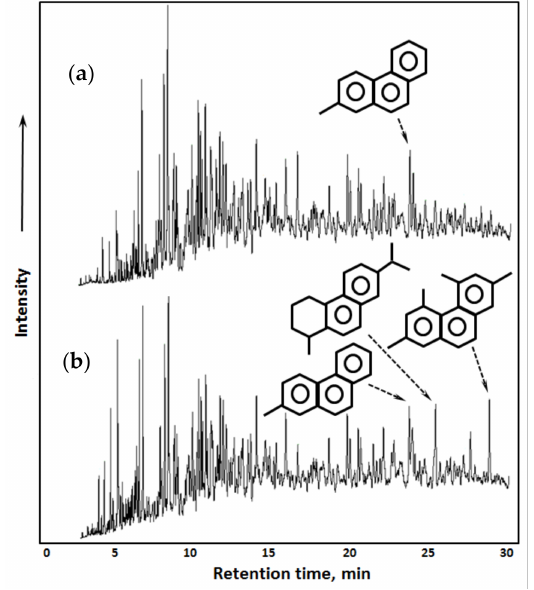
Figure 10. GC-MS chromatograms of aromatic fractions after aquathermolysis of heavy oil with various catalyst concentrations: ( a ) 0.4 wt%, ( b ) 0.8 wt% [90].